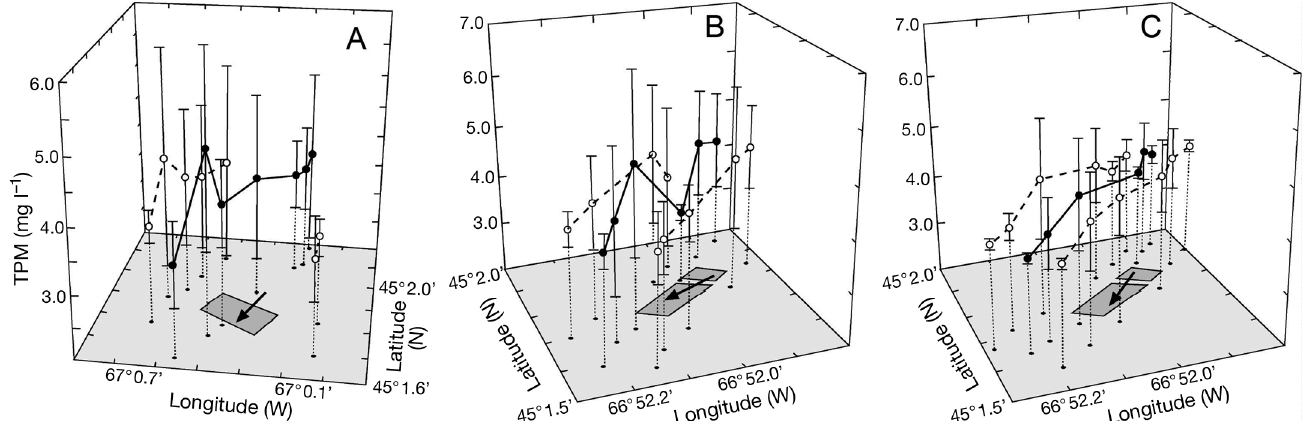
Fig. 8. Total suspended particulate matter concentrations (TPM; mg l −1 ) averaged within the 0.5−2 m depth range for selected geographic regions located along transects through the farm (closed circles and solid lines) and on either side (open circles and dashed lines). The transects were oriented along the prevailing current direction (indicated by arrows) and data from each region were extracted from Acrobat surveys of (A) the Navy Island farm on 16 June 2010, (B) the Charlie Cove farm on 5 July 2011 and (C) the Charlie Cove farm on 6 July 2011. The dotted vertical lines show the location of the center of each geographic region relative to the farm location (shaded boxes). Values are means ± 1 SD